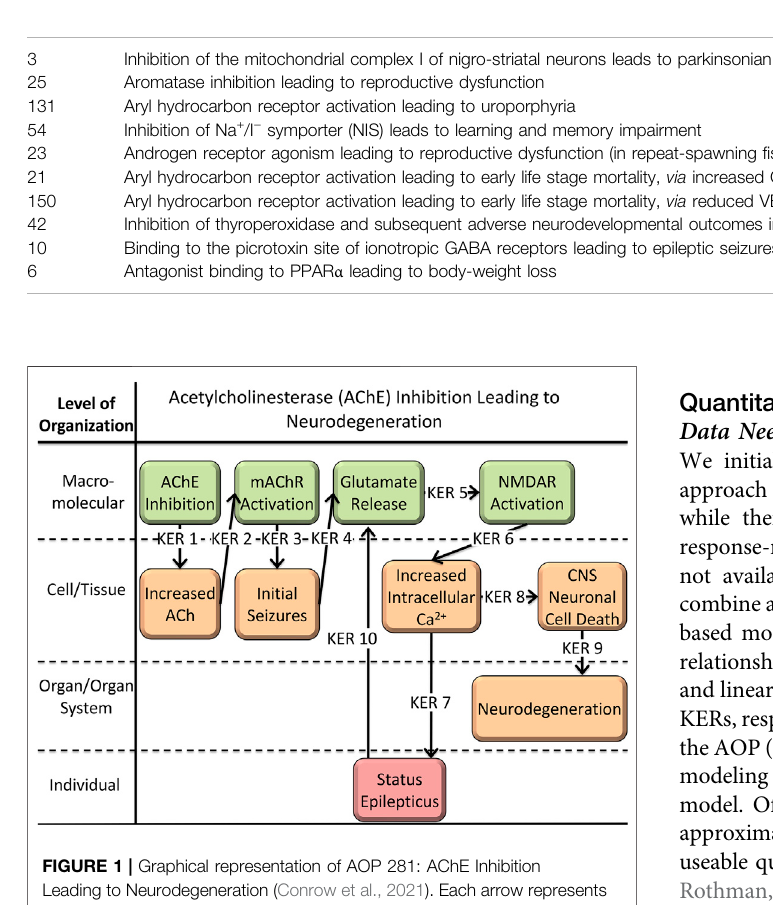
Frontiers in Toxicology |